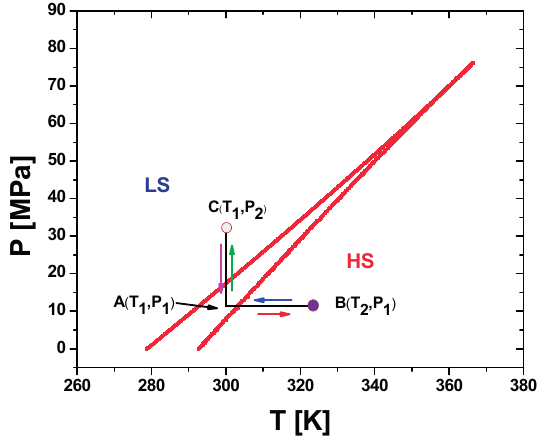
Figure 7. Pressure-temperature phase diagram calculated for a SCO system switching around the room temperature region using the following parameters values: Δ 0 /k B = 1978.6 K, δ V = 100 A 3 , ln g = 6.906 and Γ /k B = 360